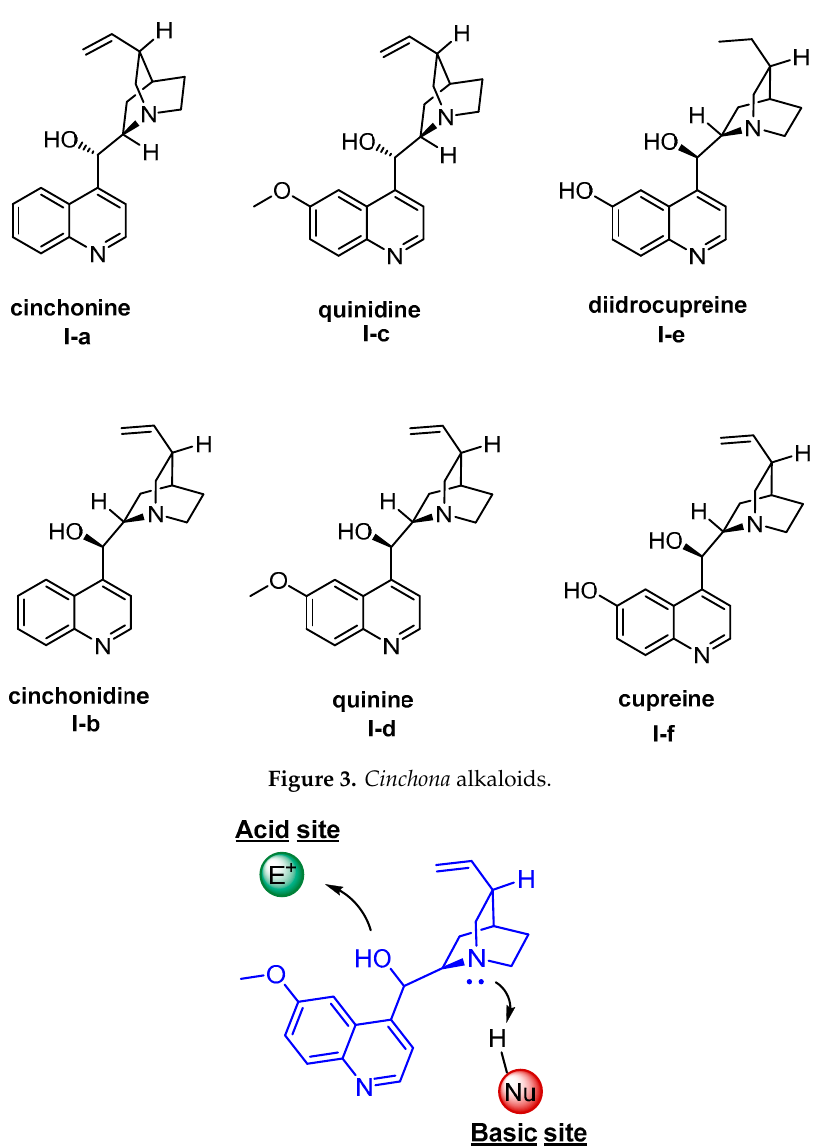
Figure 4. Cinchona alkaloids as bifunctional catalysts.